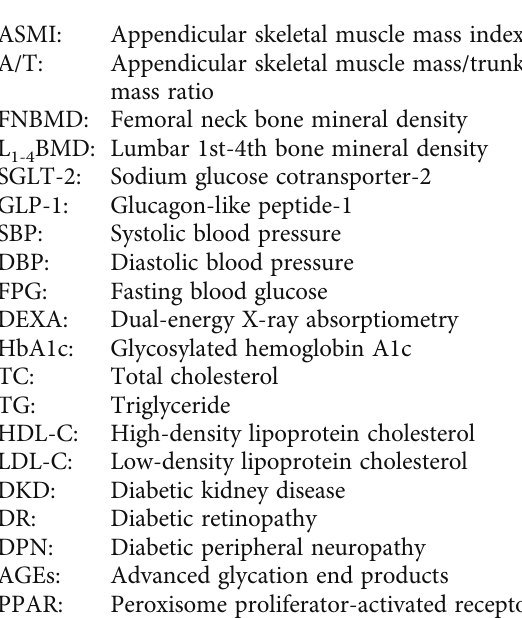
Table S1: body composition index and constituent ratio in 596 T2DM patients before and after follow-up. Table S2.1: linear regression analysis of body composition index and L1- 4BMD. Table S2.2: linear regression analysis of body composi- tion index and FNBMD. Table S3.1: frequency of body mass index and body composition index. Table S3.2: binary logistic regression analysis of body mass index, body composition index, and FNBMD reduction. (Supplementary